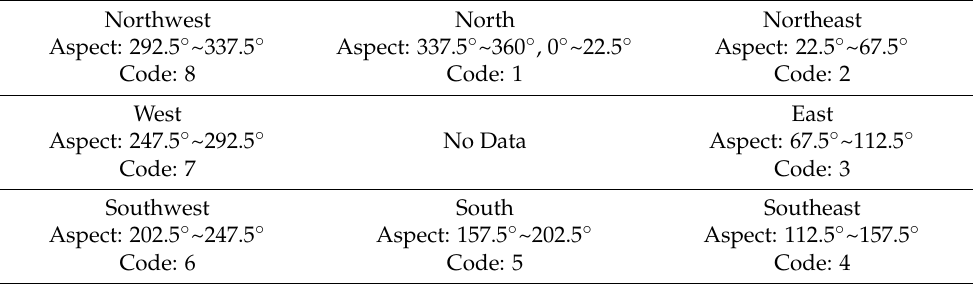
Table 2. The reclassification scheme of